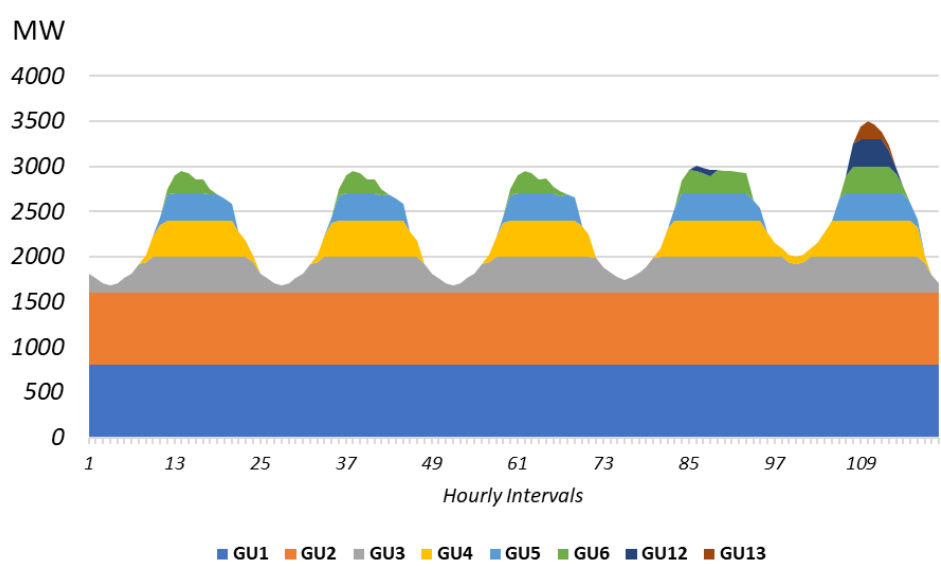
Figure 7. Power-balance violation degree during a variational Bayes optimization loop.